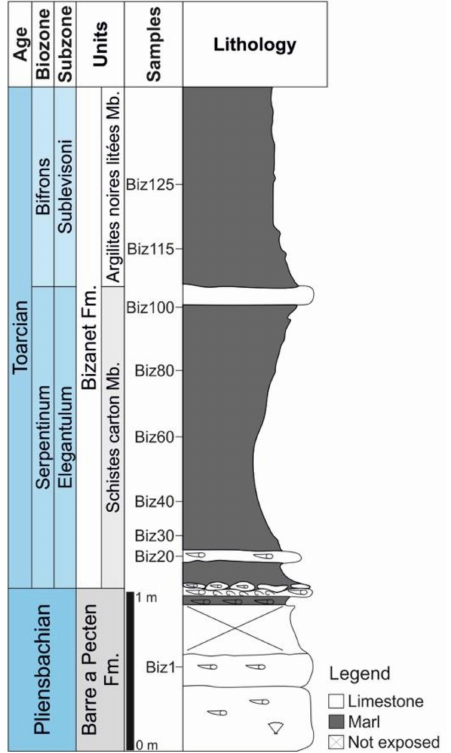
Figure 2. Stratigraphic log of the Bizanet section with sample